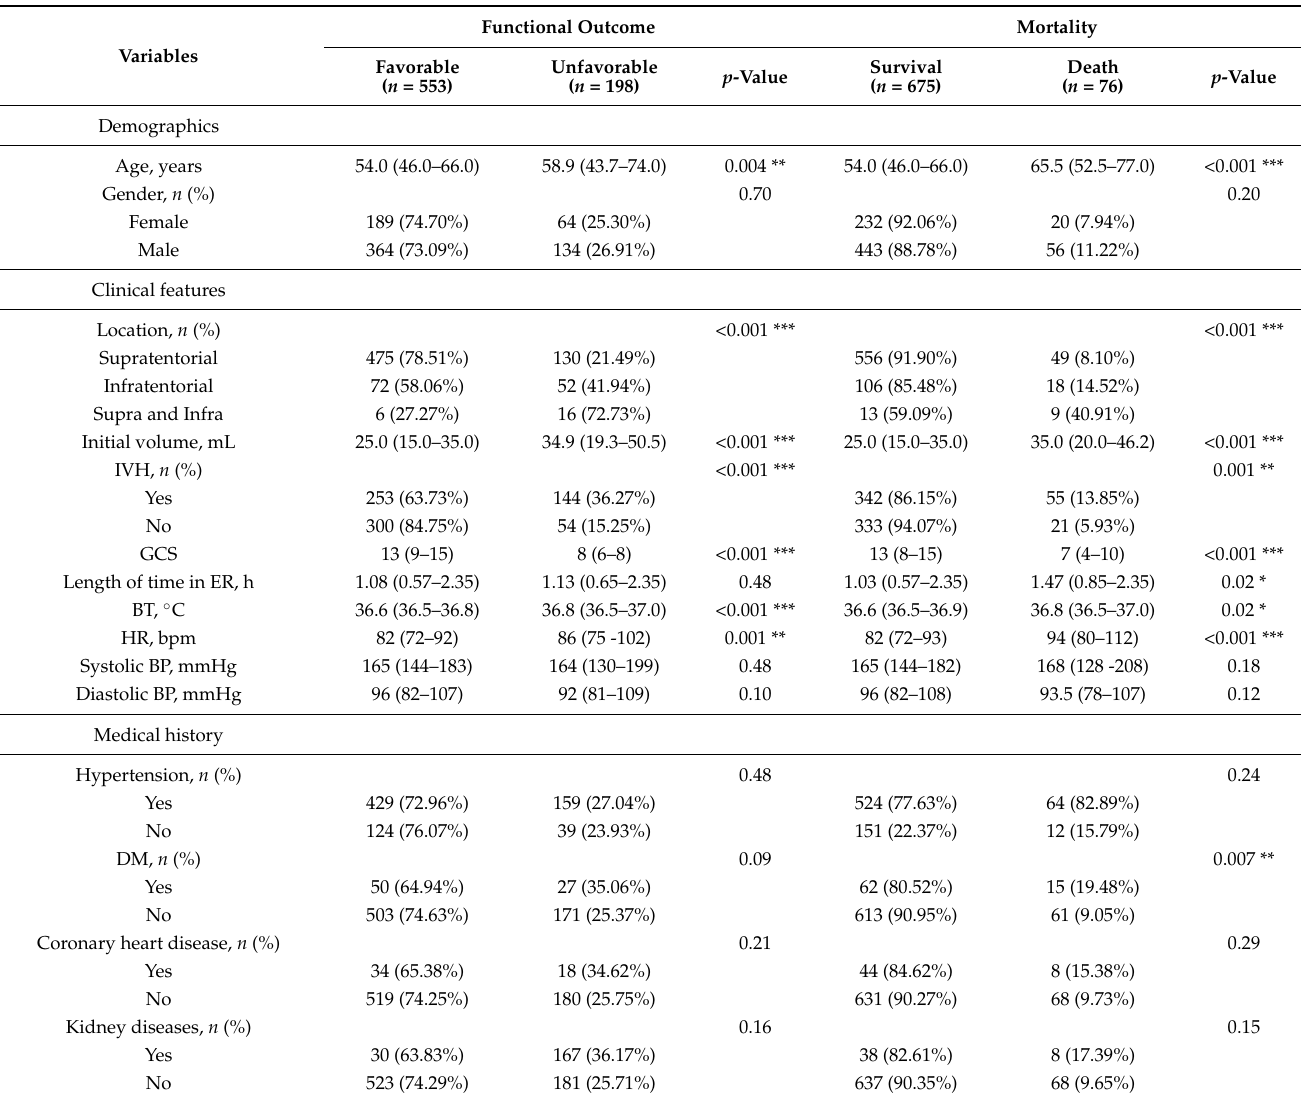
Table 1. Clinical characteristics of the patients with spontaneous intracerebral hemorrhage